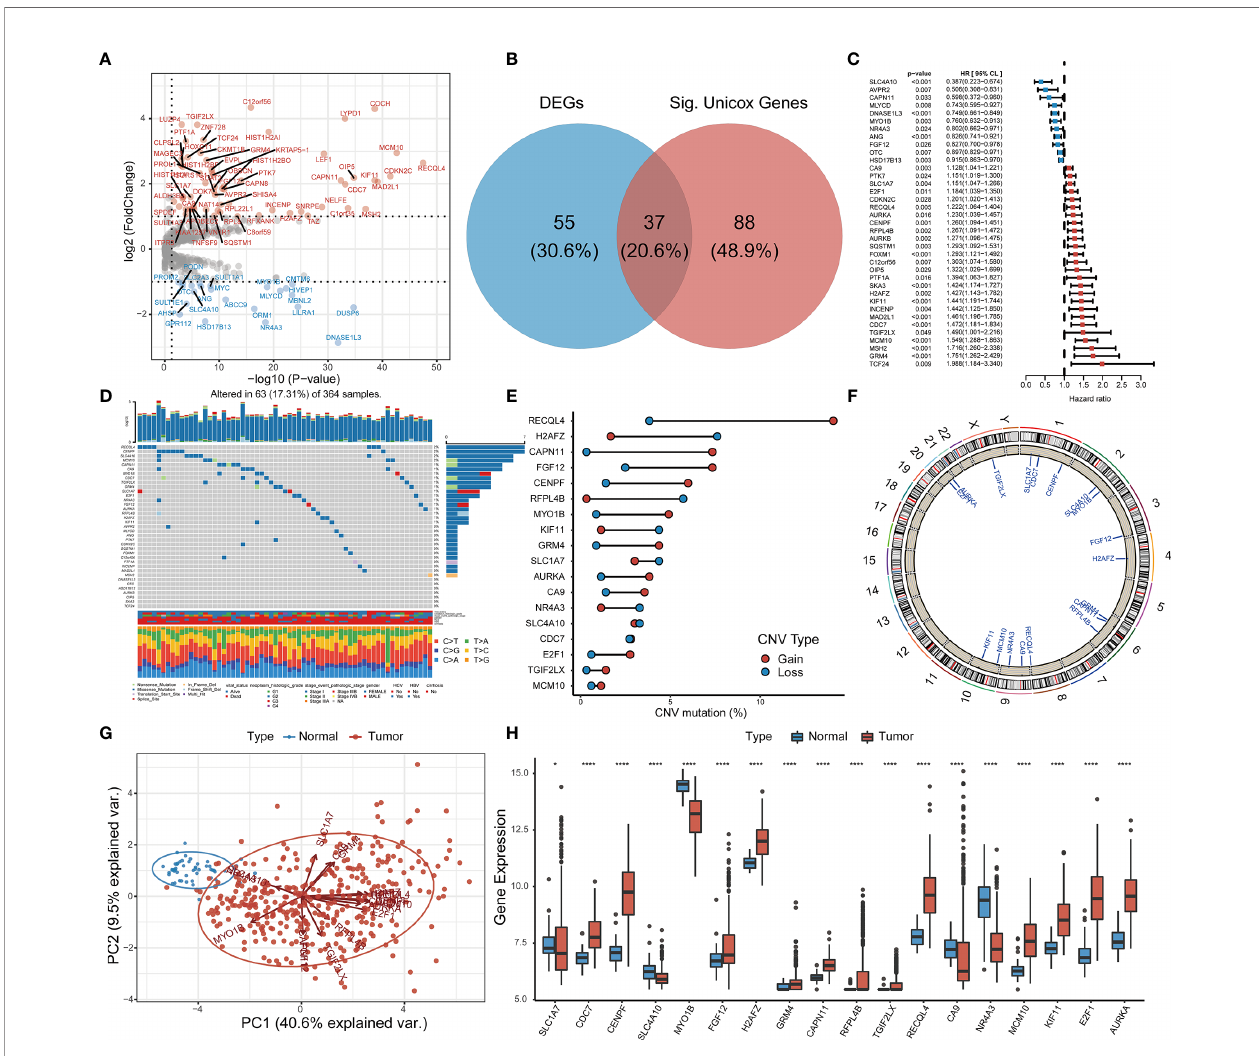
FIGURE 1 | Identi fi cation of GSTTKs and detection of mutations in liver hepatocellular carcinoma (HCC). (A) Volcano map shows 92 of 641 GSTTKs show differential mRNA expression in HCC based on transcriptome pro fi ling data for patients with HCC from TCGA-LIHC cohort. Red indicates up-regulation and blue indicates down-regulation. (B) Venn diagram shows 37 GSTTKs exhibiting both differential expression and prognostic value in HCC. (C) Univariate Cox regression analysis of 37 GSTTKs associated with clinical prognosis in HCC. (D) Waterfall plot displays the mutational landscape of the 37 GSTTKs along with clinicopathological characteristics. (E) Copy number variation (CNV) in 18 GSTTKs in HCC. Deletions, blue dots; Ampli fi cations, red dots. (F) CNV locations of 18 GSTTKs are labeled on the chromosome. (G) Principal component analysis separates tumor (green) and normal samples (red). (H) The 18 GSTTKs are differentially expressed between HCC and normal tissues. Tumor, red; Normal, blue. The upper and lower ends of boxes represent the interquartile range. Lines in the boxes represent median values, and black dots show outliers. Asterisks indicate signi fi cance, * p < 0.05; ** p < 0.01; *** p < 0.001; **** p < 0.0001; ns, no statistical signi fi